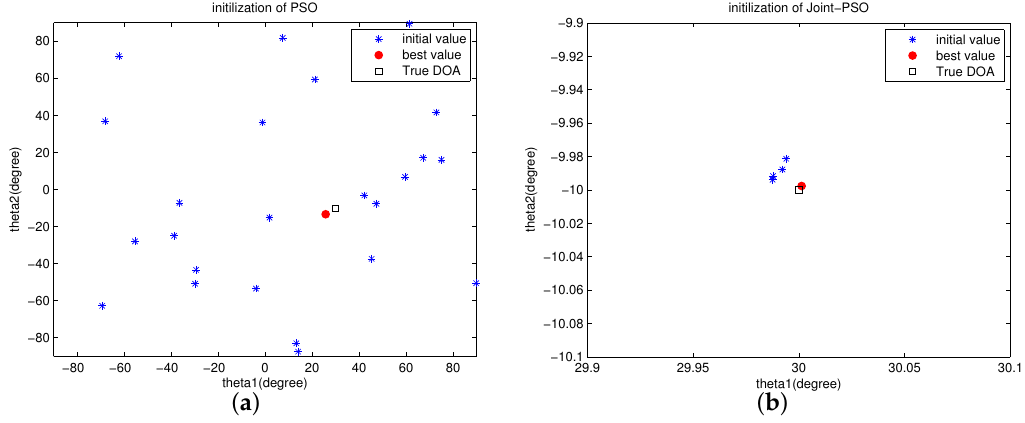
Figure 1. Initialization of conventional Particle Swarm Optimization (PSO) and Joint-PSO algorithms. ( a ) Initialization of PSO algorithm, m = 25; ( b ) Initialization of Joint-PSO algorithm, m =